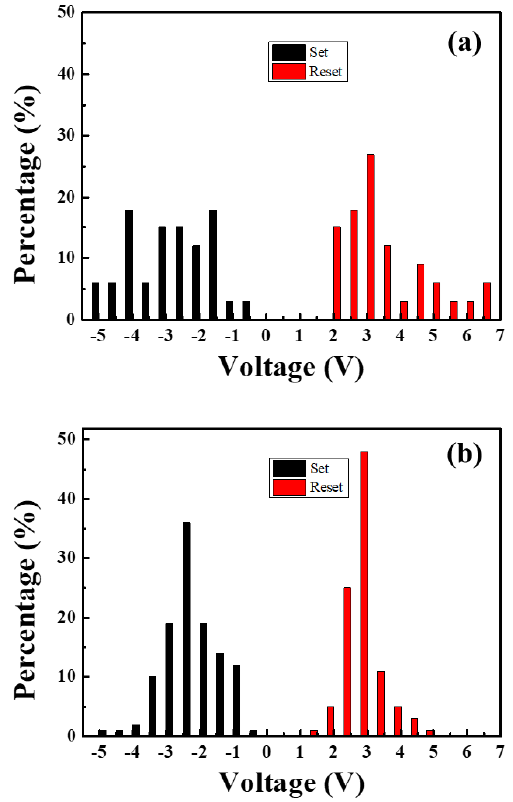
Figure 9. Set and reset voltage distributions of: ( a ) Al / MZN / ITO / glass device; and ( b ) Al / MZN NR / ITO / glass device.